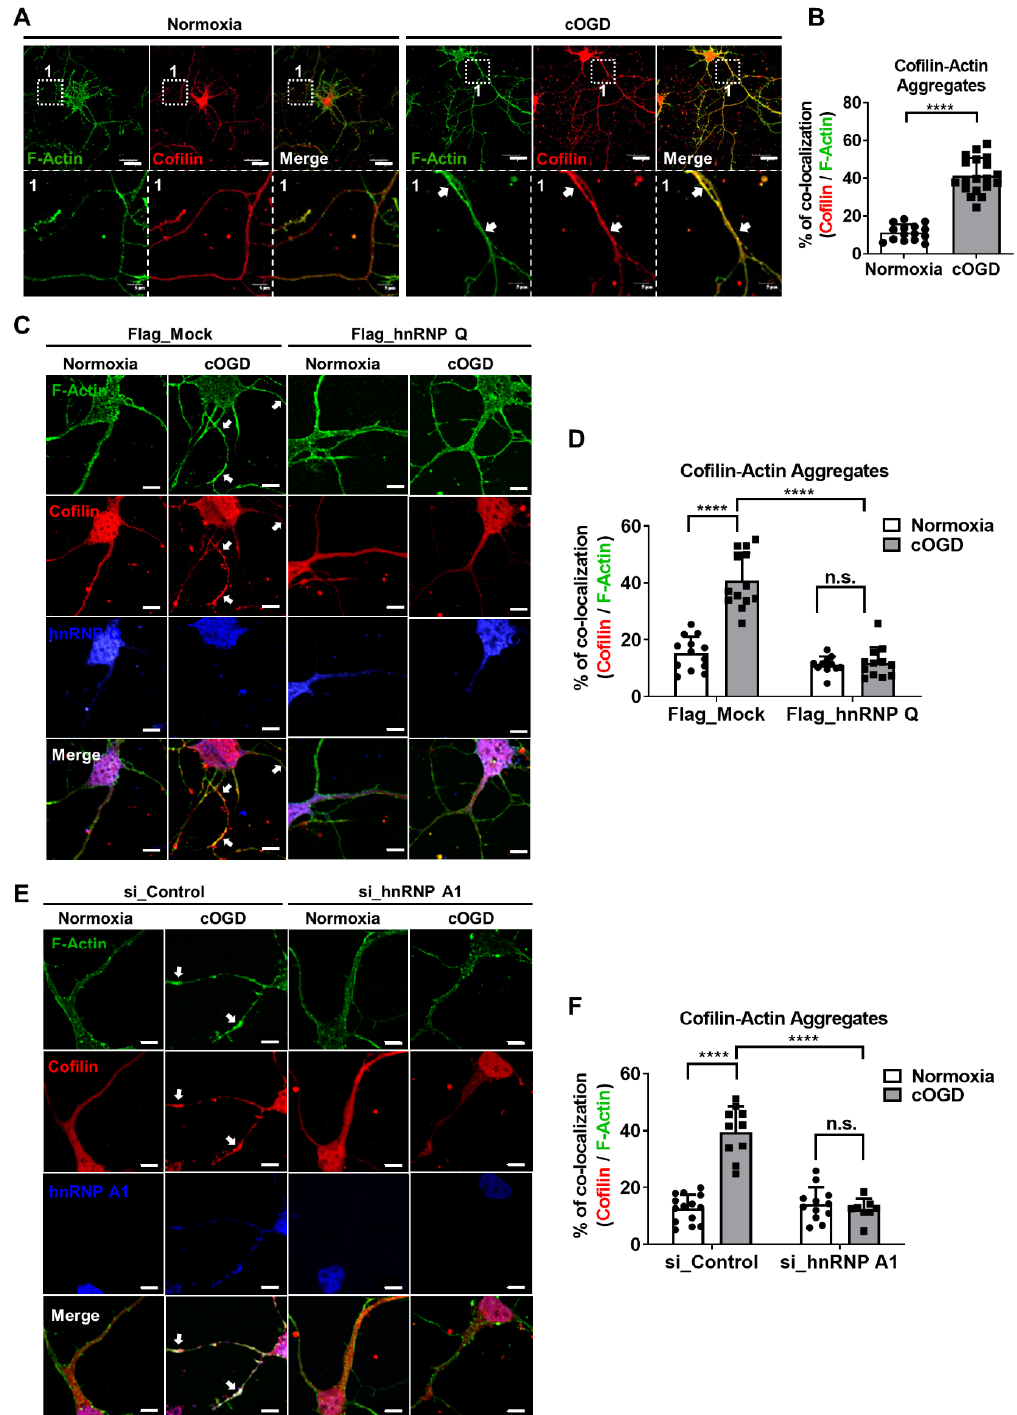
Figure 8. Changing the level of hnRNP Q and hnRNP A1 in cOGD neurons inhibits the formation of cofilin–actin aggregates. ( A ) Cofilin–actin aggregates were stained by immunofluorescence labeling of cofilin (red), and F-actin (green) in the primary hippocampal neuron that was cultured under normoxia conditions (left) and cOGD conditions (right). Cofilin–actin aggregates are indicated by the white arrowheads and are shown in scaled-up images labeled as 1. Scale bar = 30 μ M. ( B ) Quantification of cofilin–actin aggregates in primary hippocampal neurons that were cultured under normoxia condition (white) and cOGD conditions (gray) by measuring the co-localization of cofilin and F-actin ( n = 19). ( C ) Cofilin–actin aggregates were stained as previously in the Flag_Mock-expressed (left) and Flag_hnRNP Q1-expressed (right) primary hippocampal neurons that were cultured in normoxia condition (first and third column) and cOGD condition (second